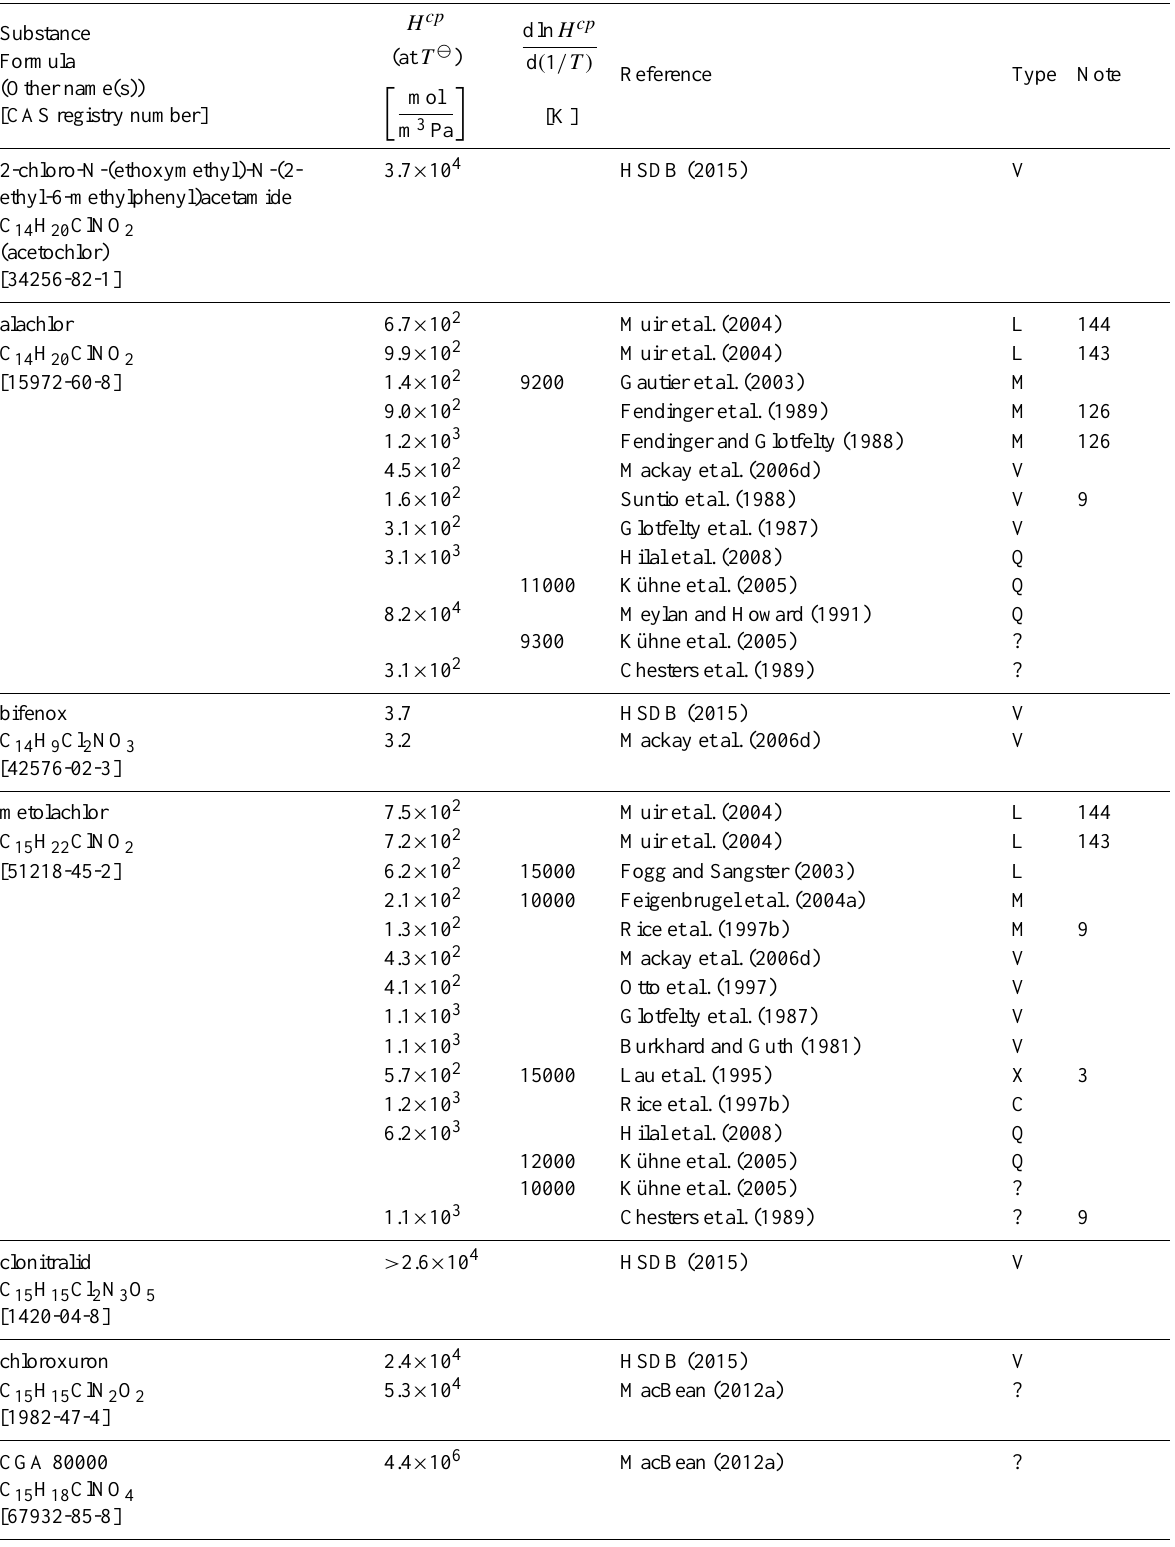
Table 6: Henry’s law constants for water as solvent